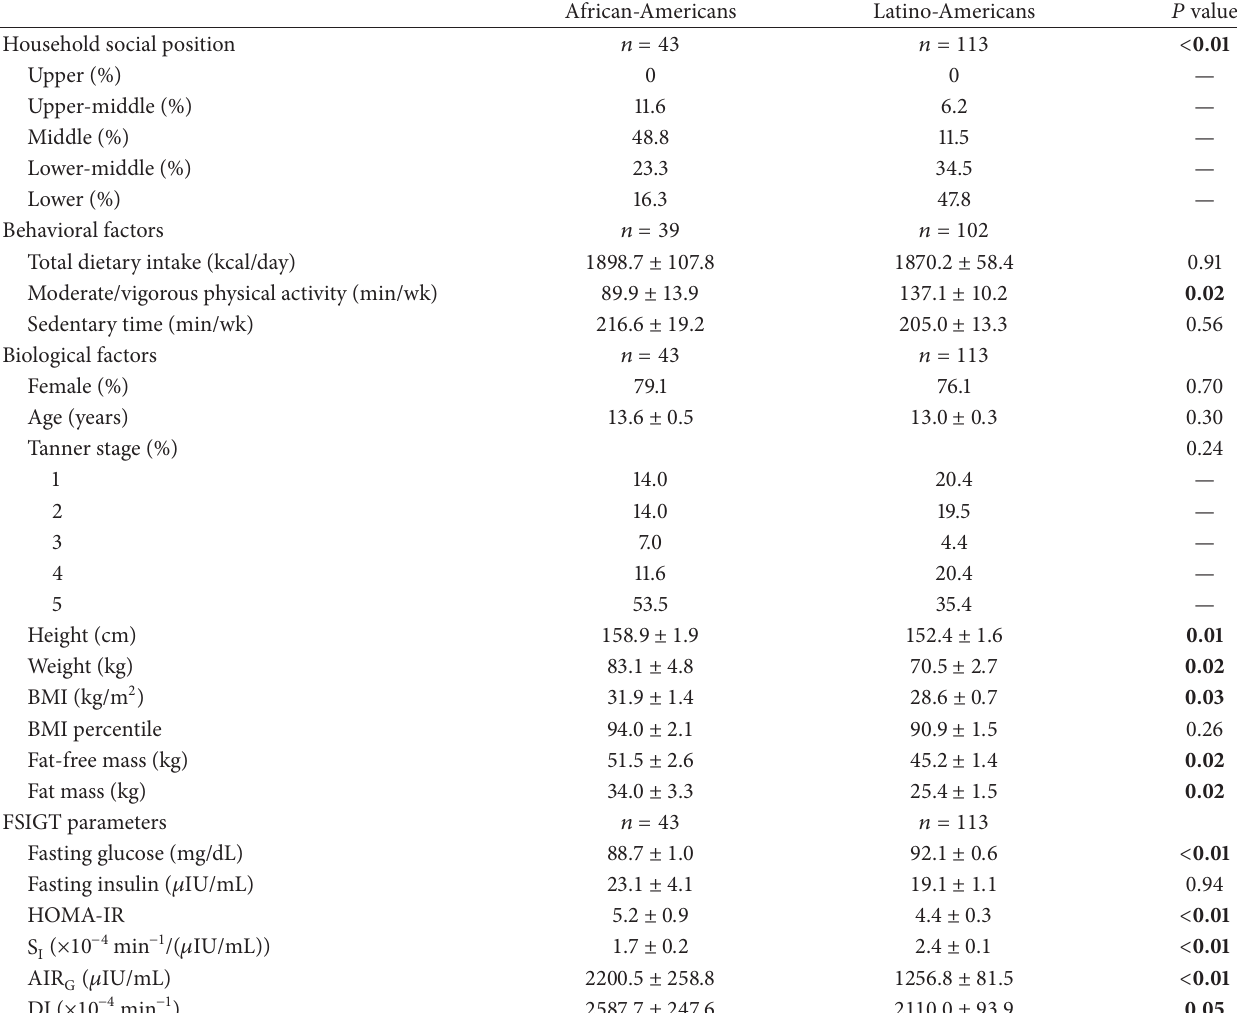
Table 2: Participant